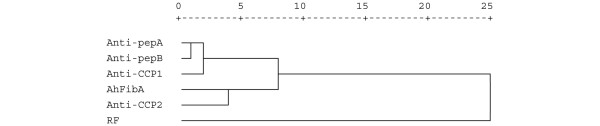
Dendrogram of the cluster analysis of the different ACPA assays in population 2. ACPA, anti-citrullinated protein/peptide antibody; AhFibA, anti-human fibrinogen (auto)antibodies; CCP, cyclic citrullinated peptide; RF, rheumatoid factor.